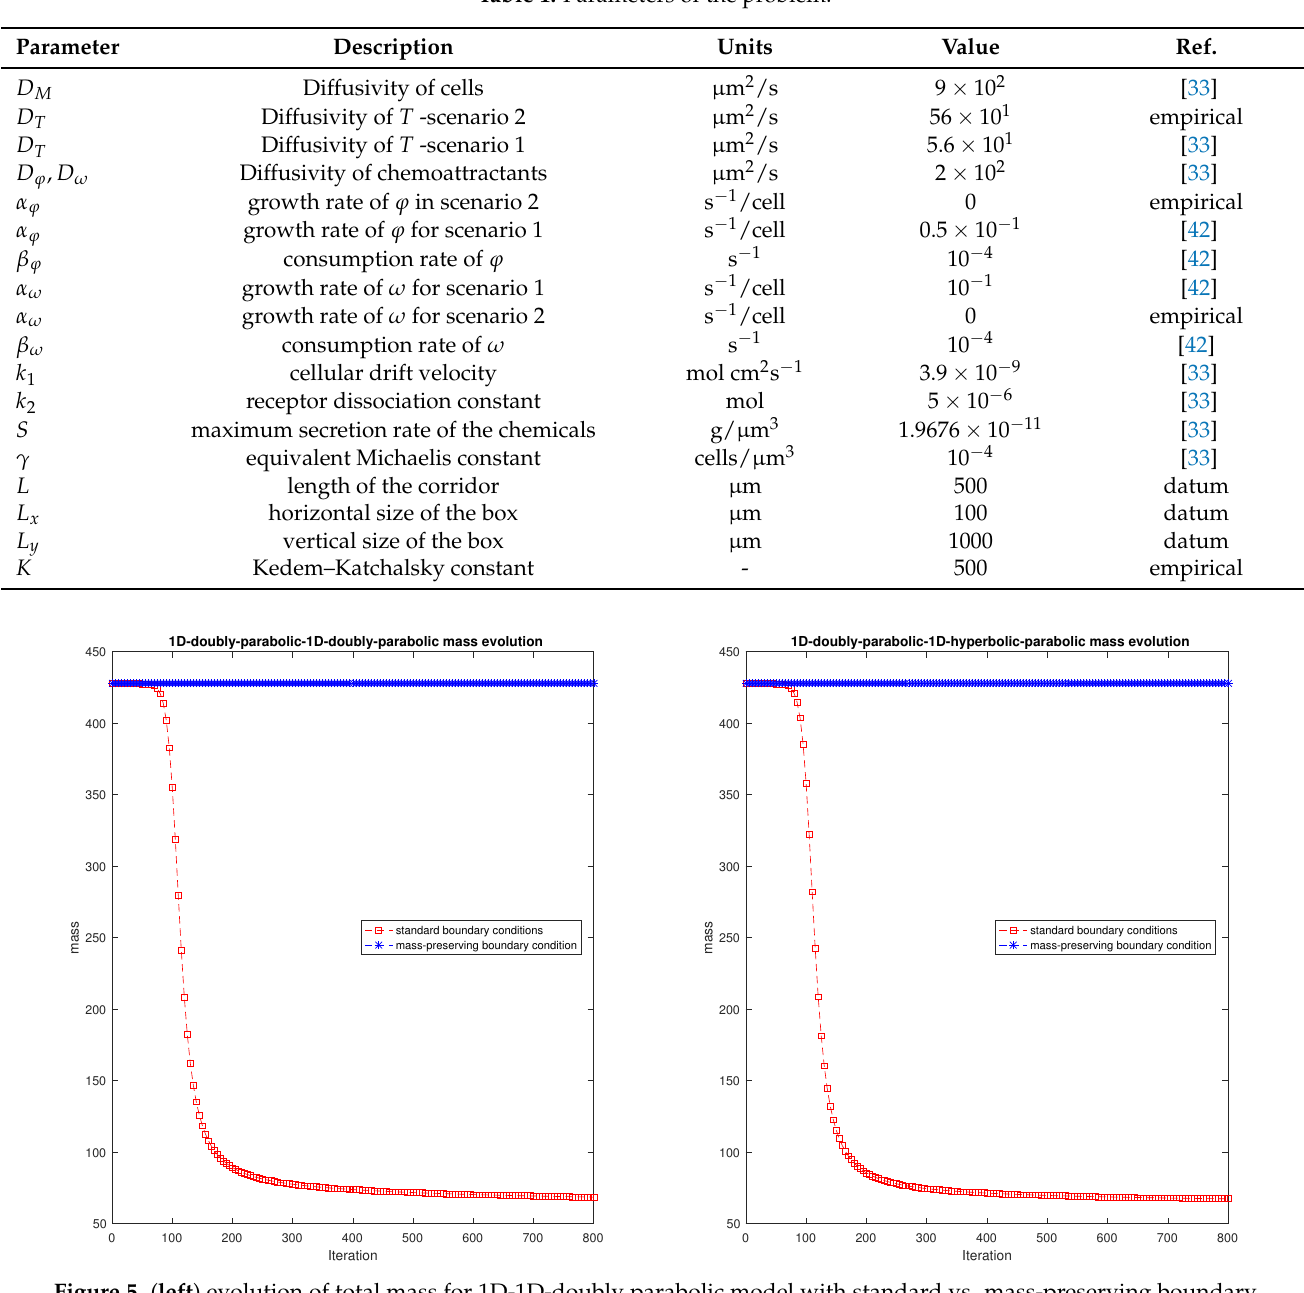
Figure 5. ( left ) evolution of total mass for 1D-1D-doubly parabolic model with standard vs. mass-preserving boundary conditions. ( right ) evolution of total mass for 1D-1D-hyperbolic-parabolic model with standard vs. mass-preserving boundary